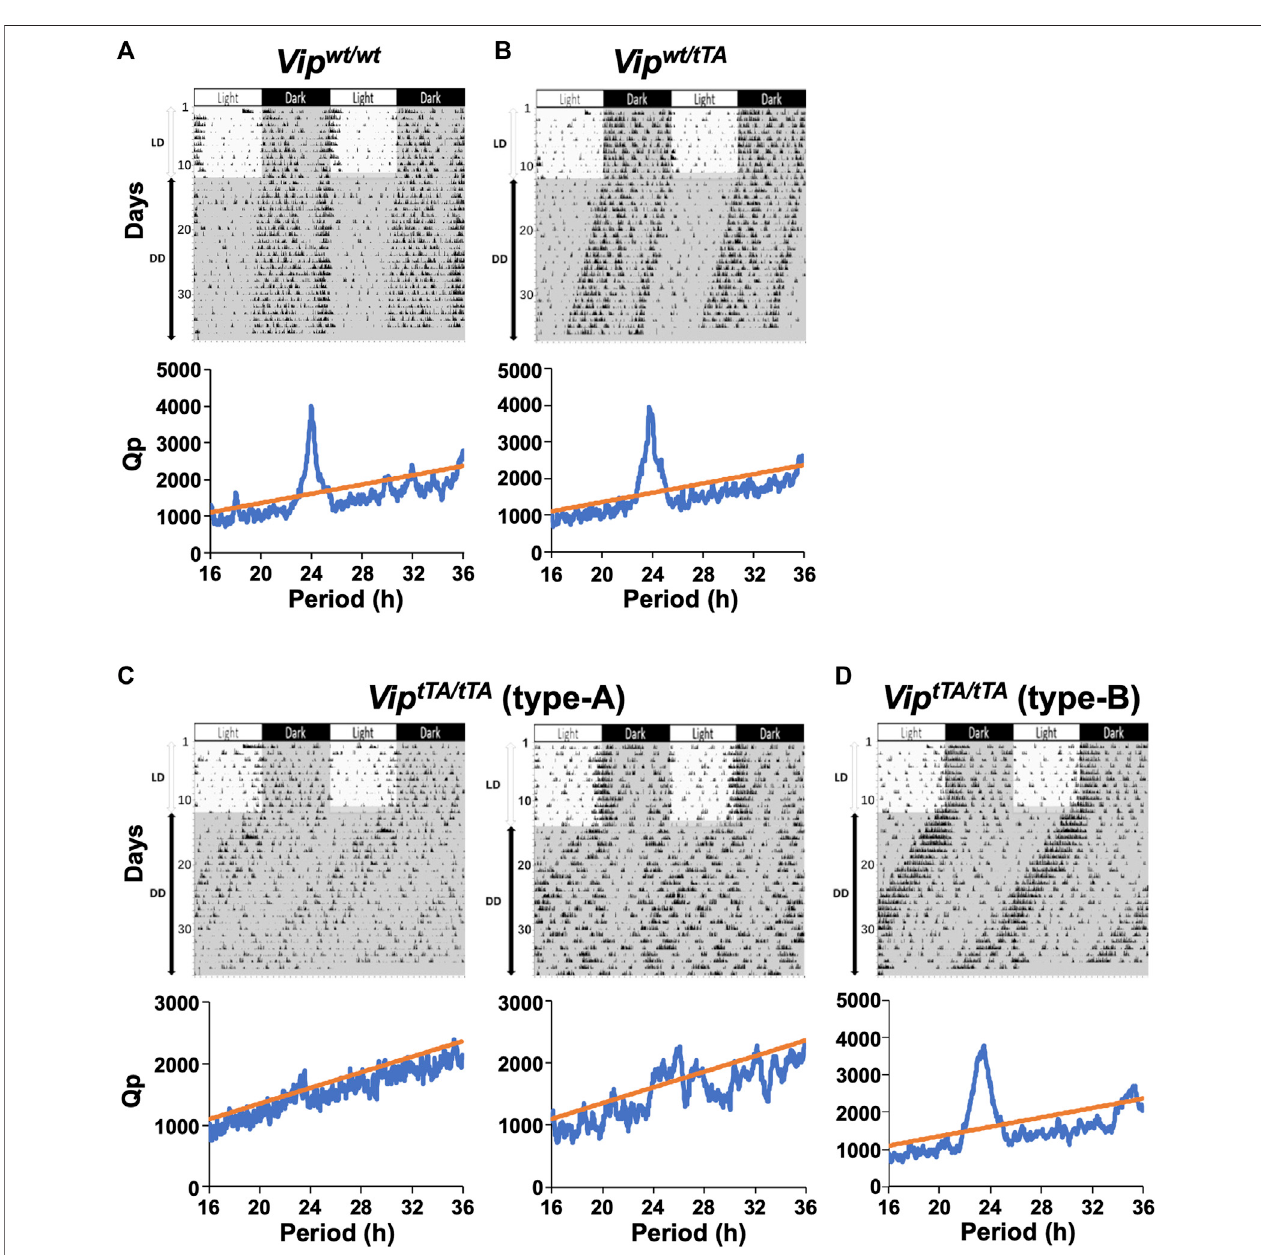
FIGURE 3 | Vip tTA/tTA mice demonstrate a variety of abnormalities in circadian rhythmicity and synchrony. (A – D) Representative actograms and periodograms of thelocomotor activityrhythm ofone Vip wt/wt (A) ,one Vip wt/tTA (B) ,twotype-A Vip tTA/tTA (C) ,and onetype-B Vip tTA/tTA mice.Animalswereinitiallyhousedin12:12 hlight/ dark (LD) conditions and then transferred to constant darkness (DD). Gray shadings in actograms indicate the time when lights were off. Periodograms are for the last 10 days in DD. Peaks above the diagonal line (indicating the 99.9% con fi dence level) between 16 and 36 h were considered signi fi cant circadian periods. Vip wt/wt and Vip wt/tTA mice show a clear dominant peak around 24 h (A,B) . Note that type-A Vip tTA/tTA mice expressed no clear period (i.e., arrhythmic; C left) or multiple periods (C right), whereas those of type-B showed more coherent circadian behavior, with a single, free-running period, although shortened (D)